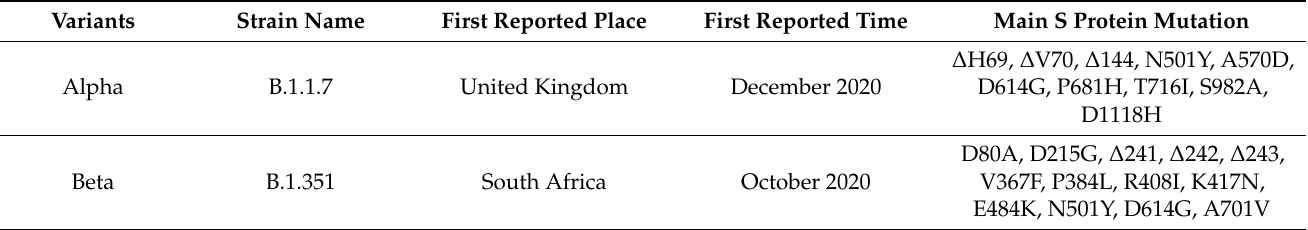
Table 1. Information of main SARS-CoV-2